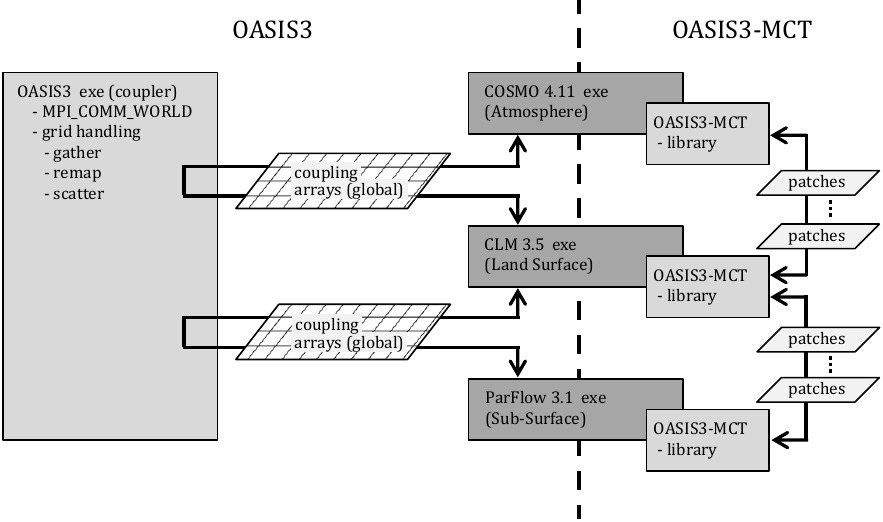
Figure 4. Schematic of the coupling in TerrSysMP with OASIS3 (left) and OASIS3-MCT (right). OASIS3 is a separate executable, and coupling arrays are repartitioned to the full domain by OASIS. OASIS3-MCT is part of each component model, and coupling arrays only consist of the local fraction of the full domain and are routed by OASIS to the destination